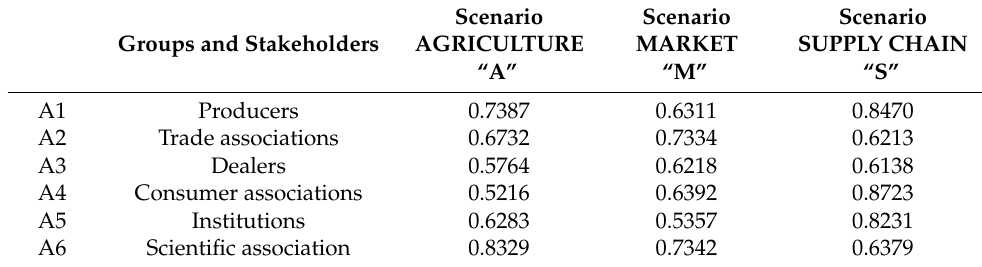
Table 3. Scenarios by maximum consensus level obtained and their classification. Groups and Stakeholders